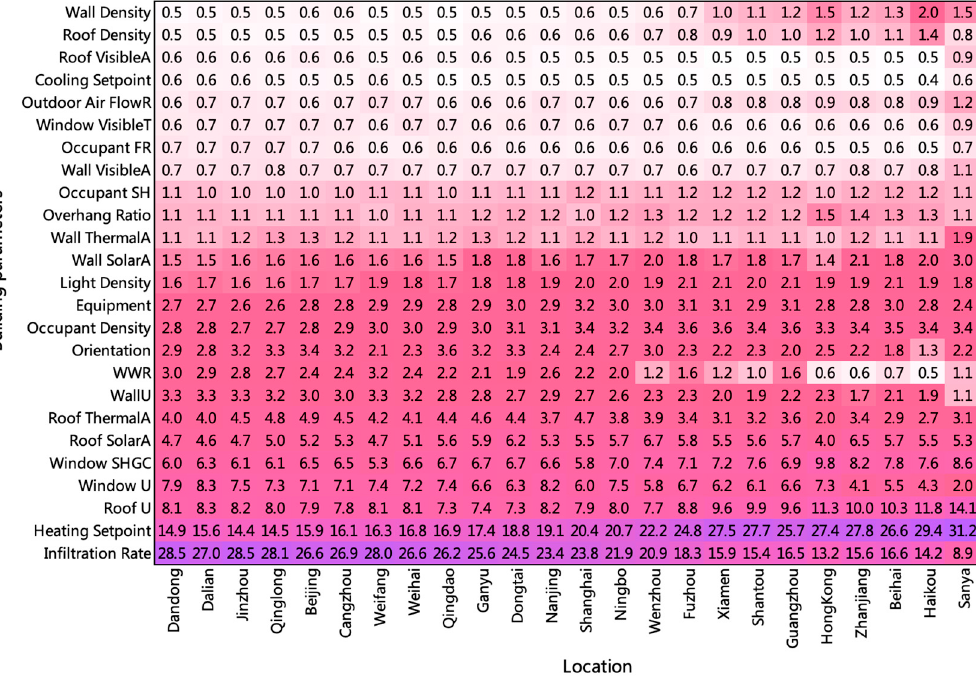
Figure 9. PI of input parameters in district heating demand.